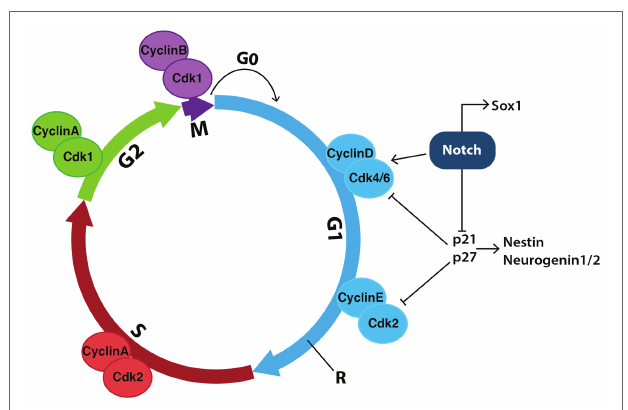
FIGURE 8 | Notch signaling in neural stem cells promotes cell-cycle progression and inhibits neurogenesis. During the mammalian cell cycle, the length of time it takes cells to move through interphase (G1, S and G2) and, in particular, how long they spend in G1, helps determine their fate. Transition between stages of the cell cycle is driven by a series of cyclin- dependent kinases (Cdks) binding to specific cyclins to promote cell-cycle progression. Notch signaling increases the expression of both CyclinD and Cdk4/6, indirectly allowing cells to progress past the restriction checkpoint (R) and into S phase, promoting proliferation. Notch also inhibits the cell-cycle inhibitors p21 and p27, which further promotes proliferation and prevents the expression of genes involved in neurogenesis such as Nestin and Neurogenin1/2